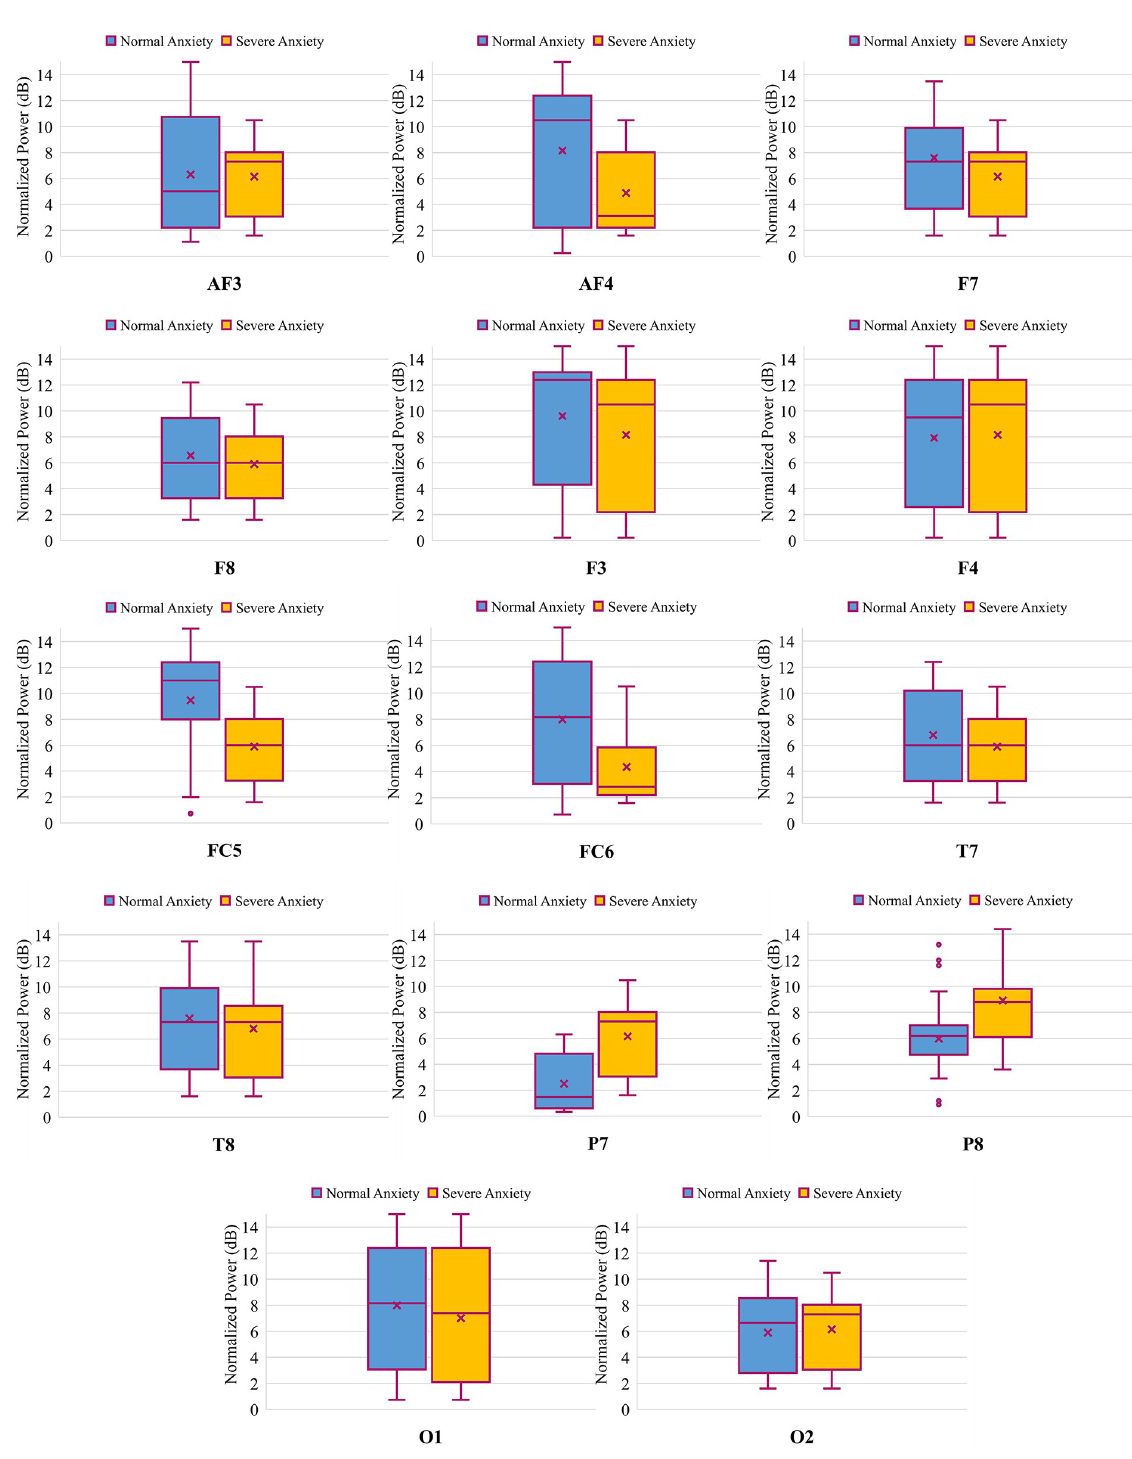
Fig 5. Box-and-whisker diagram of the power obtained from each channel of the Emotiv EPOC headset for binary anxiety classification.